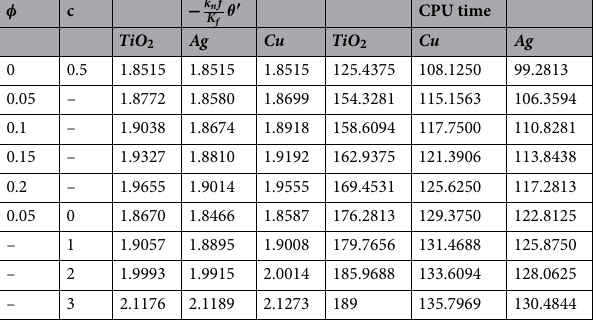
θ ′ for various values of volume fraction φ and c . For ζ f 6.2 =